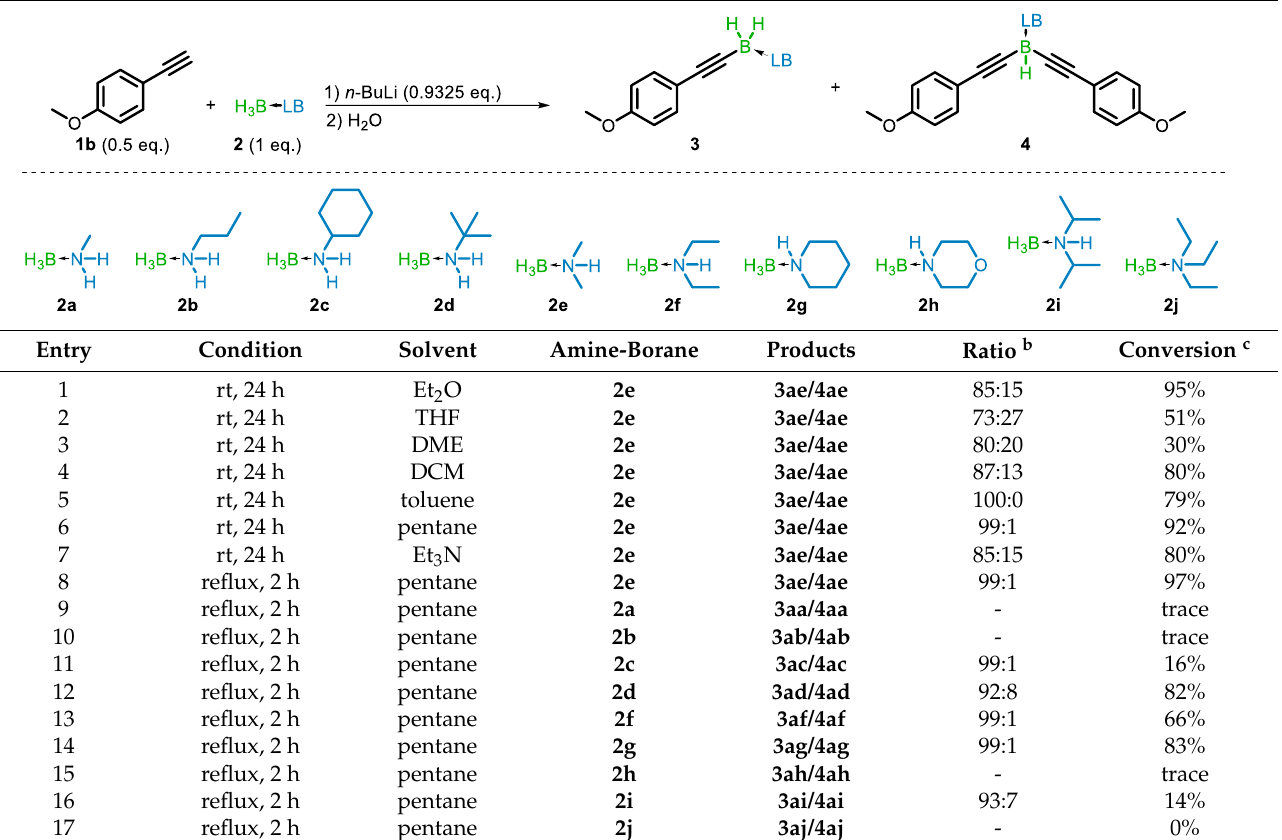
Table 1. Optimization of the reaction solvent and amine-borane a .